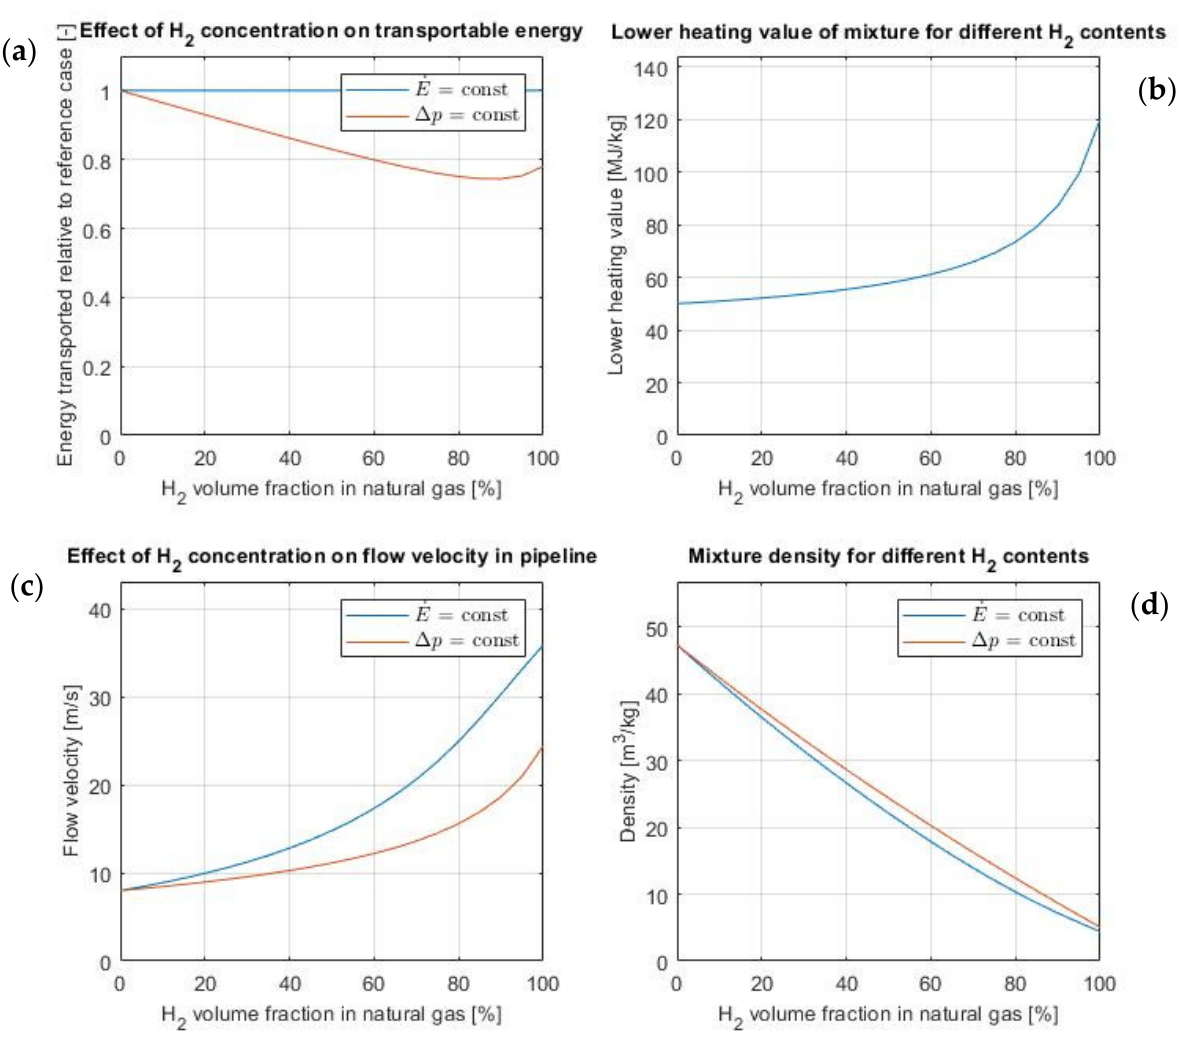
Figure 4. ( a ) Transported energy, ( b ) lower heating value, ( c ) flow velocity, and ( d ) density as a function of H 2 volume fraction in NG.